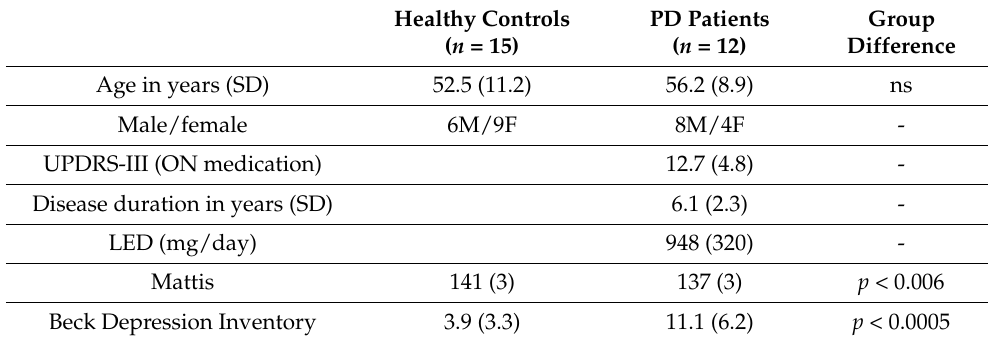
Table 1. Demographic and clinical characteristics of the